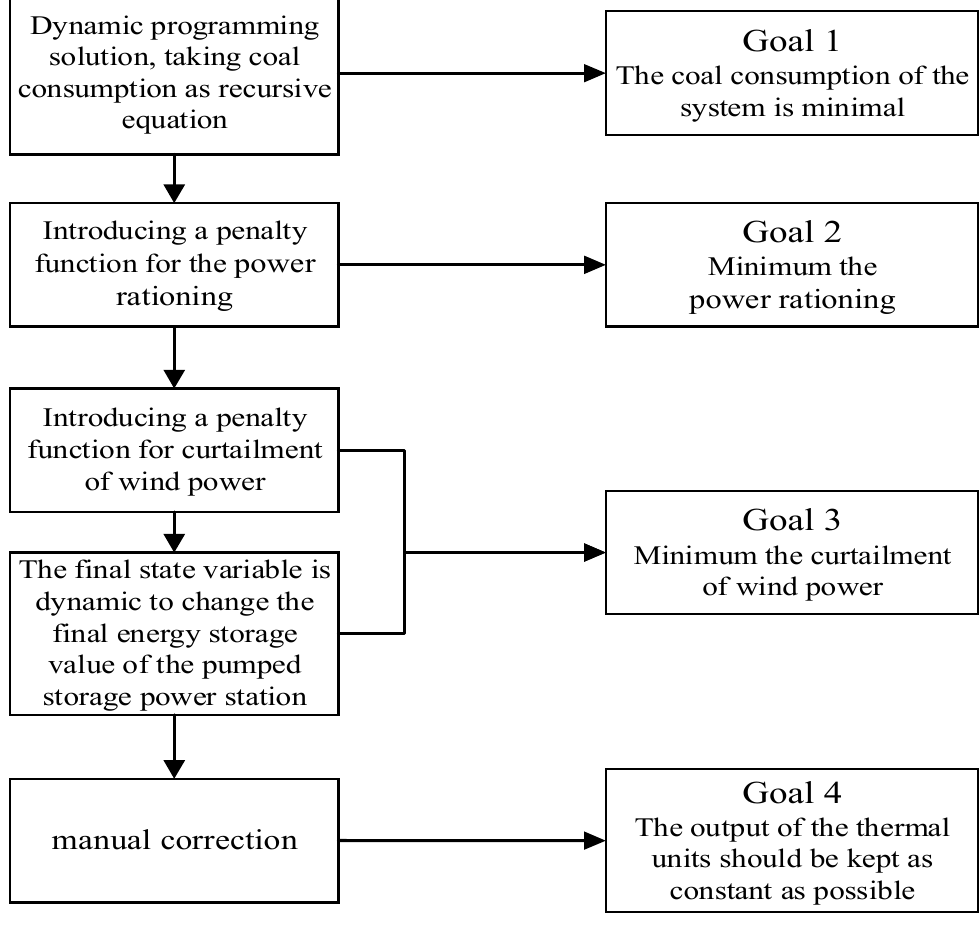
Figure 1. The realization of multiple goals.